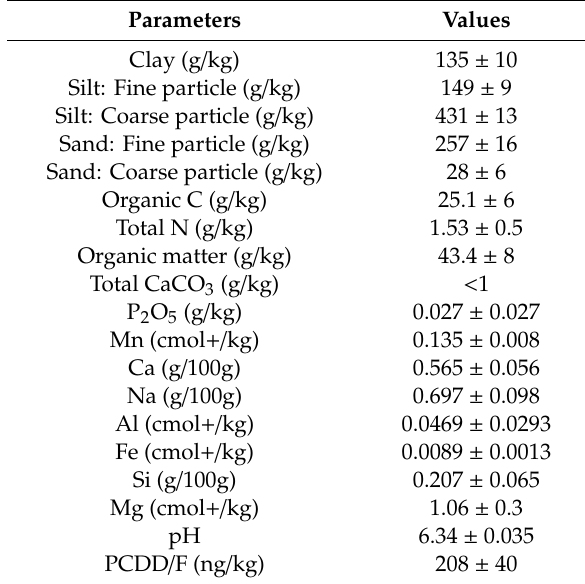
Table 1. Physico-chemical parameters of the aged polluted sterilized